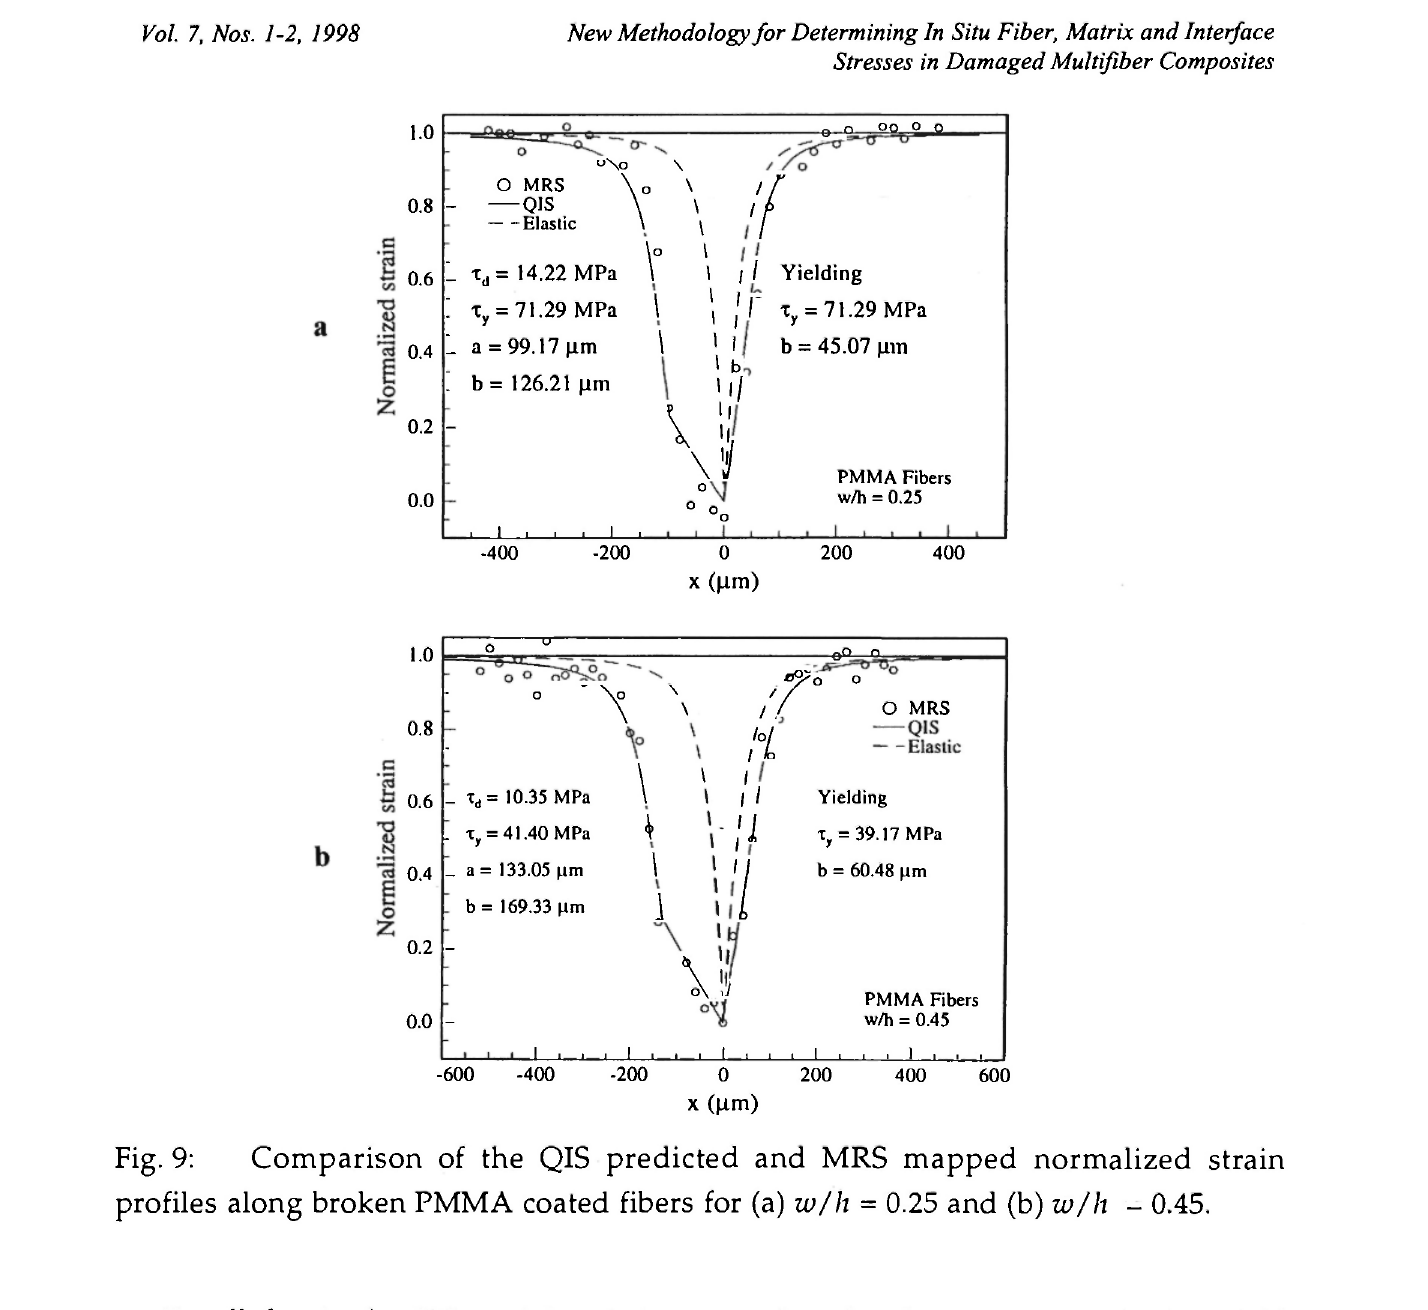
Fig. 9: Comparison of the QIS predicted and MRS mapped normalized strain profiles along broken PMMA coated fibers for (a) w/h = 0.25 and (b) w/h -